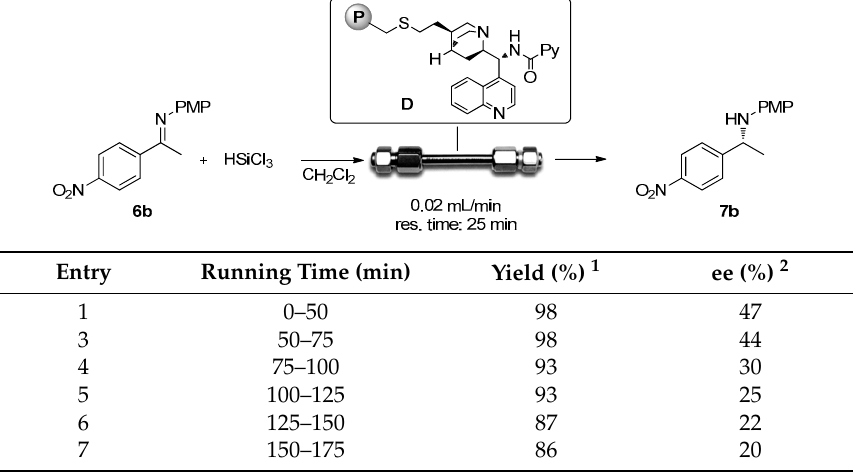
Table 3. Continuous flow stereoselective reduction of imine 6b with HSiCl 3 .